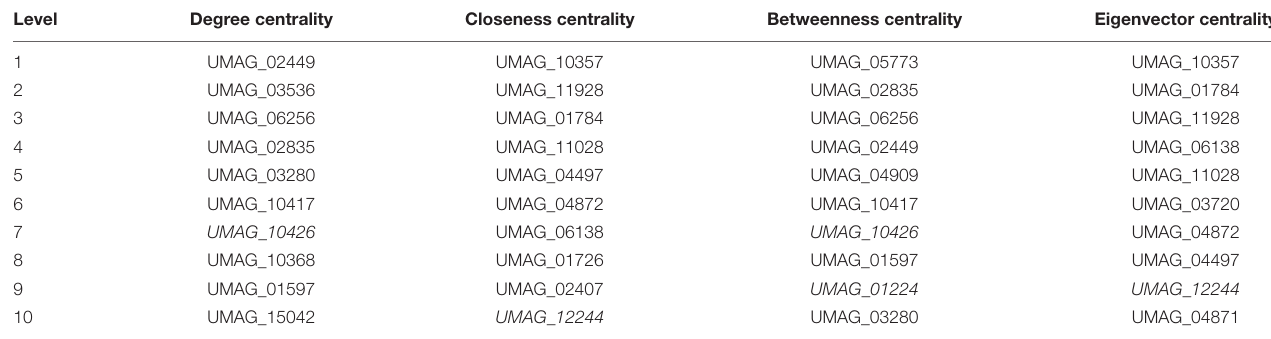
TABLE 4 | Centralities of top 10